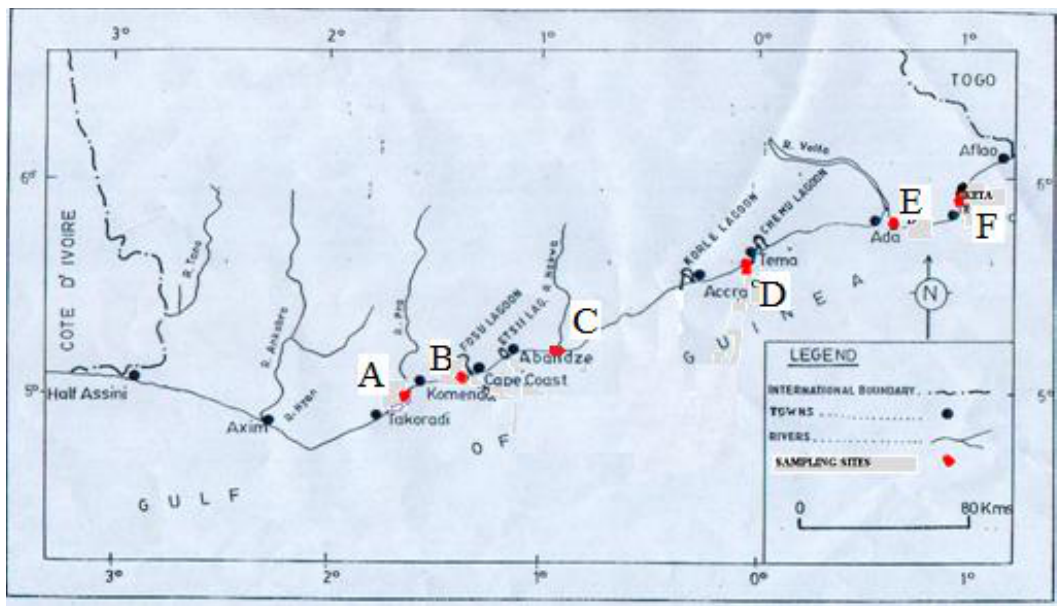
FIGURE 1 . Map of southern Ghana showing the sample sites. A = Pra estuary, B = Benya lagoon, C = Narkwa lagoon, D = Sakumono lagoon, E = lower Volta, F = Keta